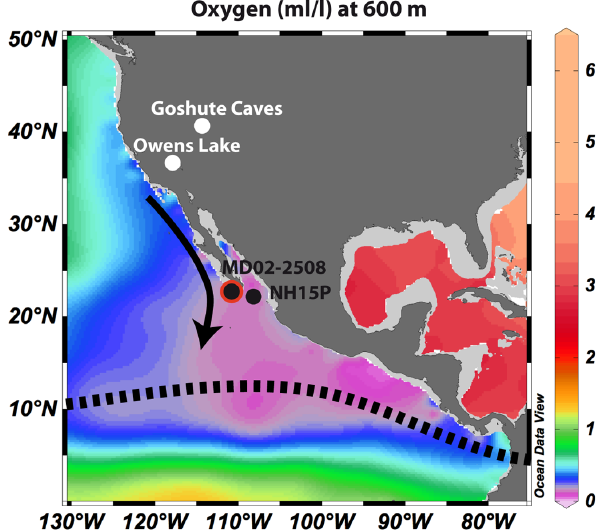
Fig. 1. Dissolved oxygen content at 600m in northeastern Pa- cific (World Ocean Atlas 09, Garcia et al., 2010) and positions of the records discussed in the text. Cores MD02-2508 (this study); NH15P (Ganeshram and Pedersen, 1998; Nameroff et al., 2004); Goshute Cave (Denniston et al., 2007); Owens Lake (Li et al., 2004). Black arrow indicates dominant winds during upwelling sea- son and black dotted line represents ITCZ position during boreal summer. Figure 1 was generated using the Ocean Data View soft- ware (http://odv.awi.de).